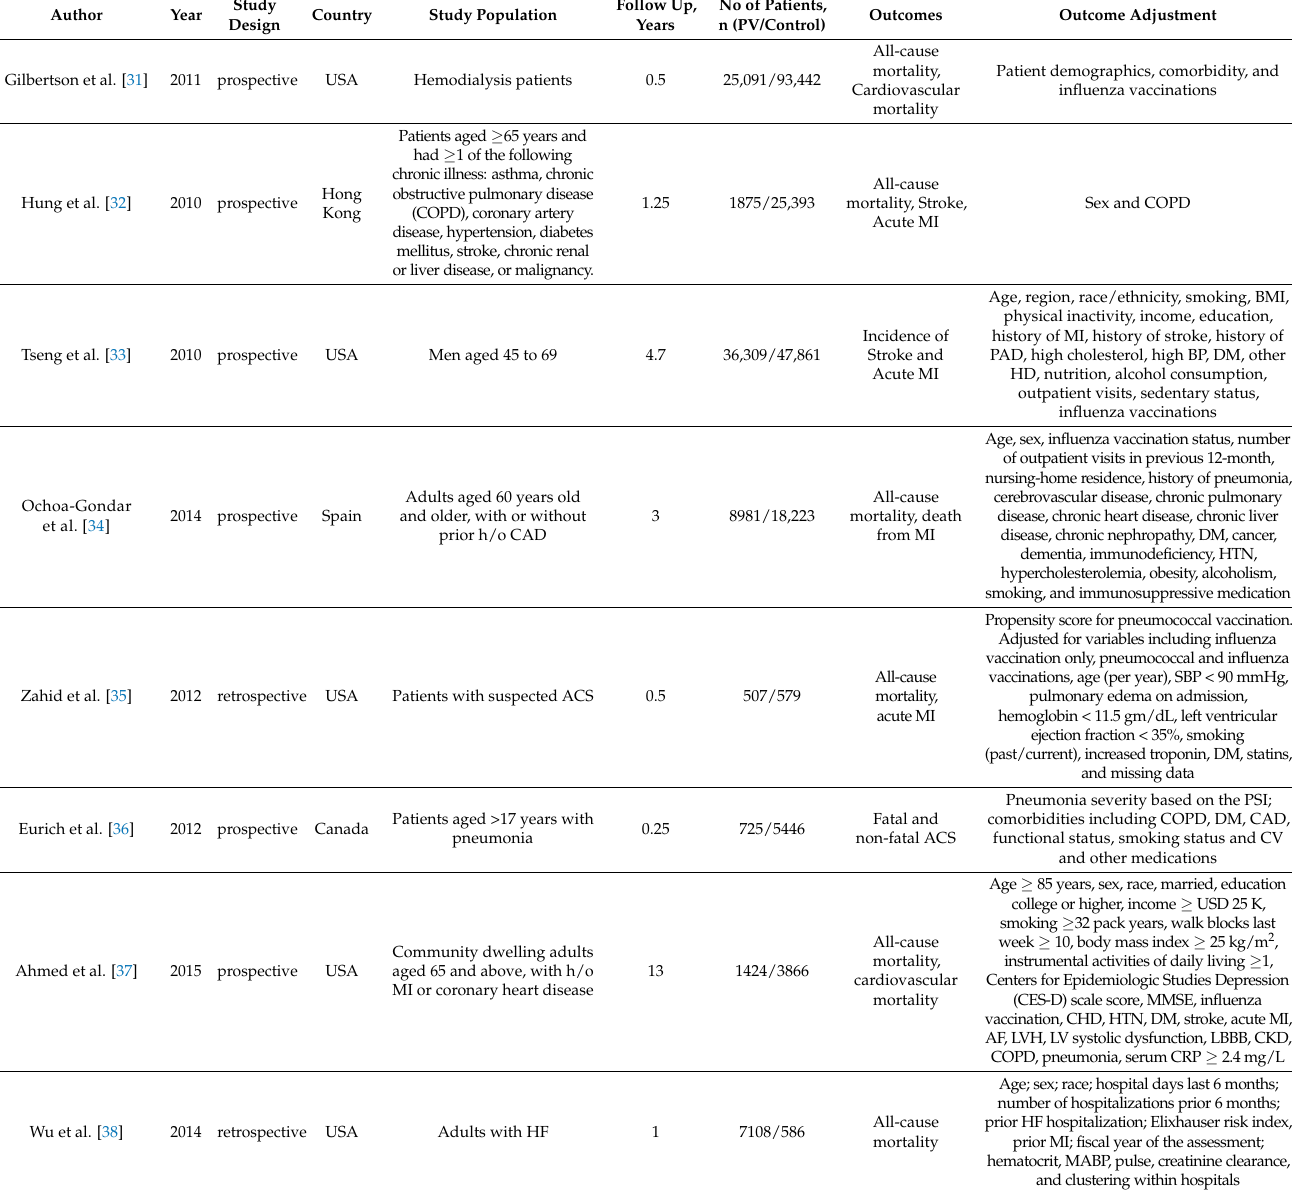
Table 1. Characteristics of included